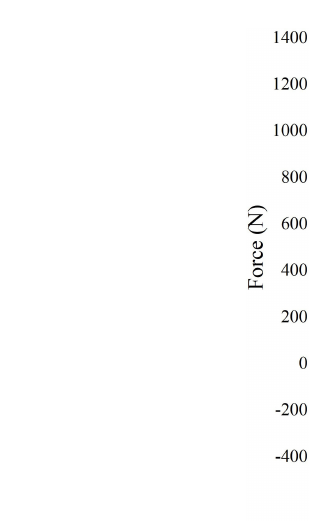
FIGURE 8 Penetration resistance in three types of clay.